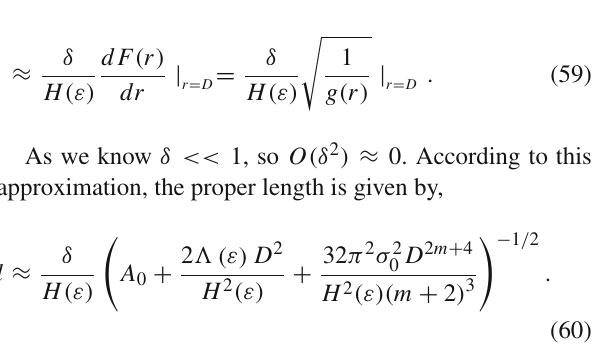
δ = 0 . 01, A = 1, (cid:8)(ε) = − 1, m = 2 and H (ε) = 1 . 1 0